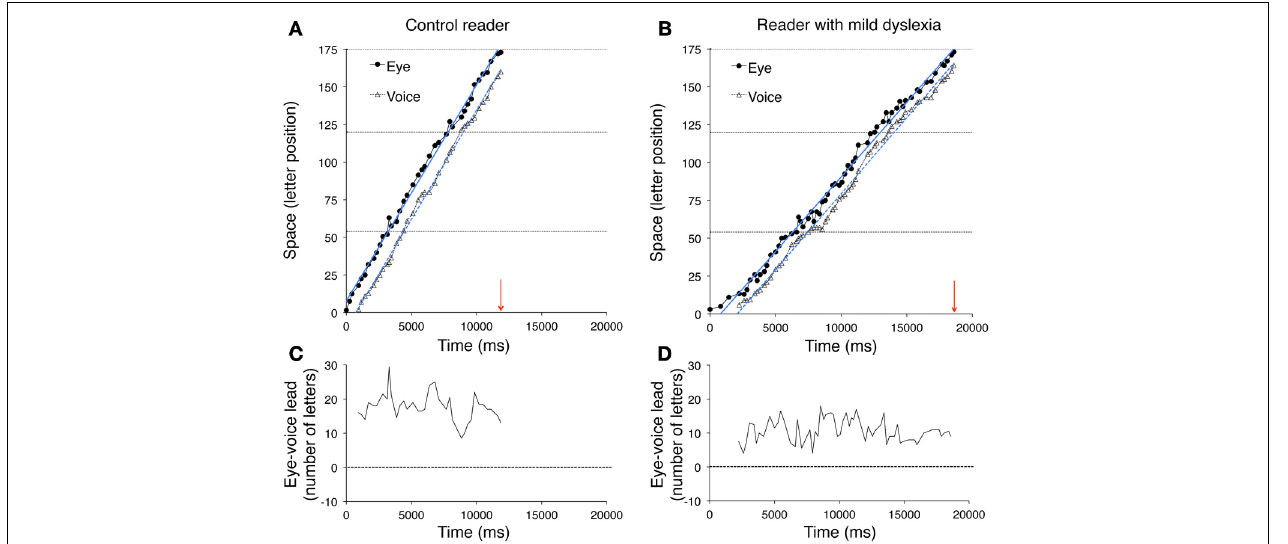
FIGURE 5 | The pairs of fixated grapheme/uttered phoneme positions are plotted as a function of time for a typically developing reader (A) and a child with mild dyslexia (B). The horizontal dashed lines represent the end of the first, second and third line of the sentence, from bottom to top, respectively. The arrows on the abscissa indicate the overall time necessary to read the three lines for each reader. Filled circles and open triangles represent fixations (i.e., eye position data) and utterances (i.e., voice position data), respectively. The ordinate reports the spatial position measured in number of